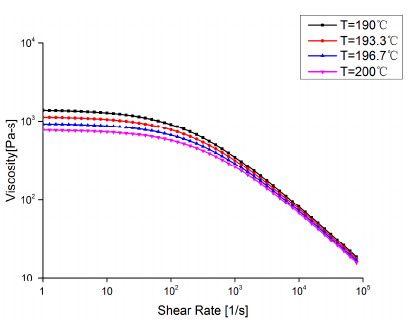
Figure 5. The rheological properties of poly- L -lactic acid (PLLA) with crystalline melt mass-flow rate (MFR) of 0.55 g/min measured under the conditions of a temperature of 200 °C and a load of 5 kg.